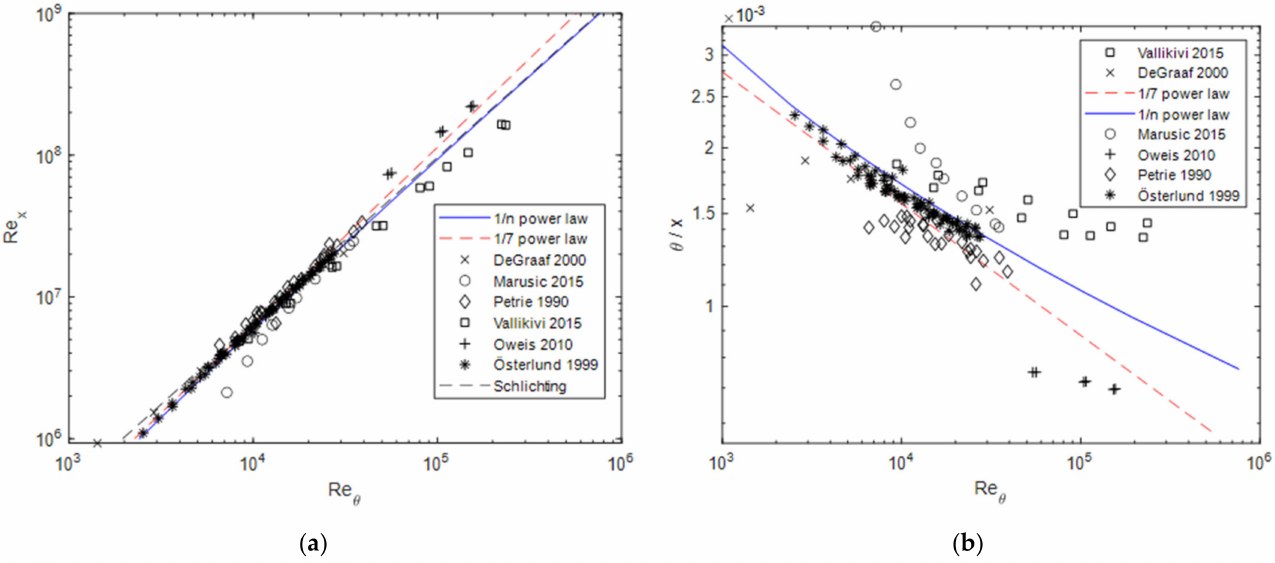
Figure 4. ( a ) Reynolds number based on x plotted over the Reynolds number based on θ ; ( b ) momen- tum thickness from different experiments and formulae plotted over Re θ